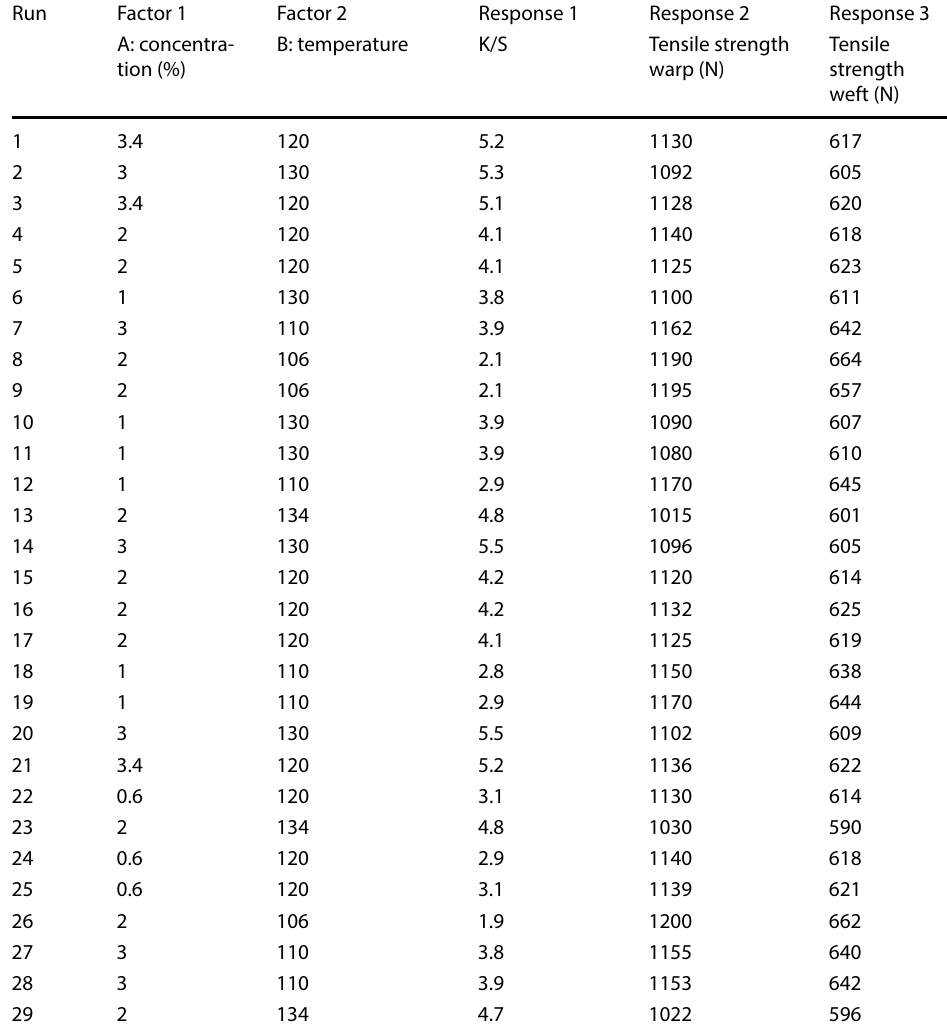
Table 3 Experimental design and results of modified PC blend dyeing